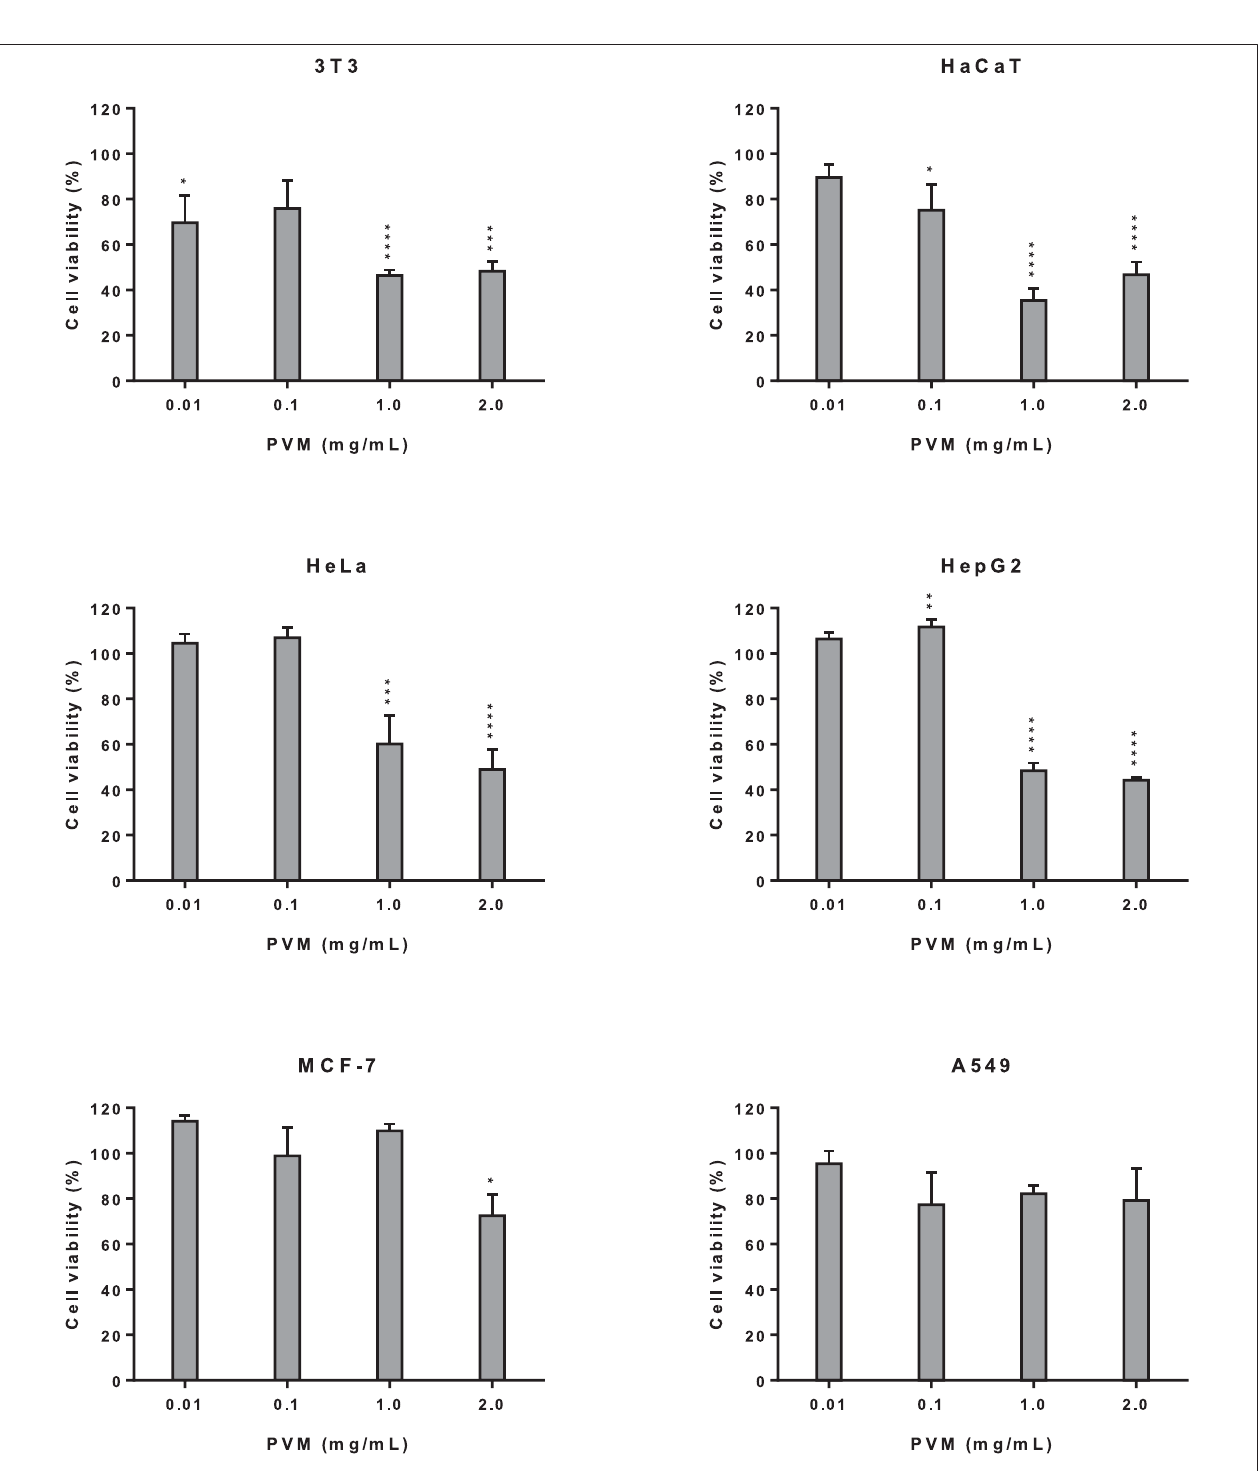
FIGURE 2 | Cytotoxicity activity of PVM in 3T3, HaCaT, HeLa, HepG2, MCF-7 and A549 cell lines by MTT assay and expressed as percentage of cell viability respecttocontrolcells.Resultsareexpressedasmean ± standarderrorof n (cid:2) 3.Controlcellsweremaintainedonlywithculturemedium.Atwo-wayanalysisofvariance (ANOVA)andaBonferroni posthoc assayhavebeenperformed.Statisticaldifferenceswereconsideredasfollows:* p ≤ 0.05,** p ≤ 0.01,*** p ≤ 0.001and**** p ≤ 0.0001 compared with no treated cells (negative control).